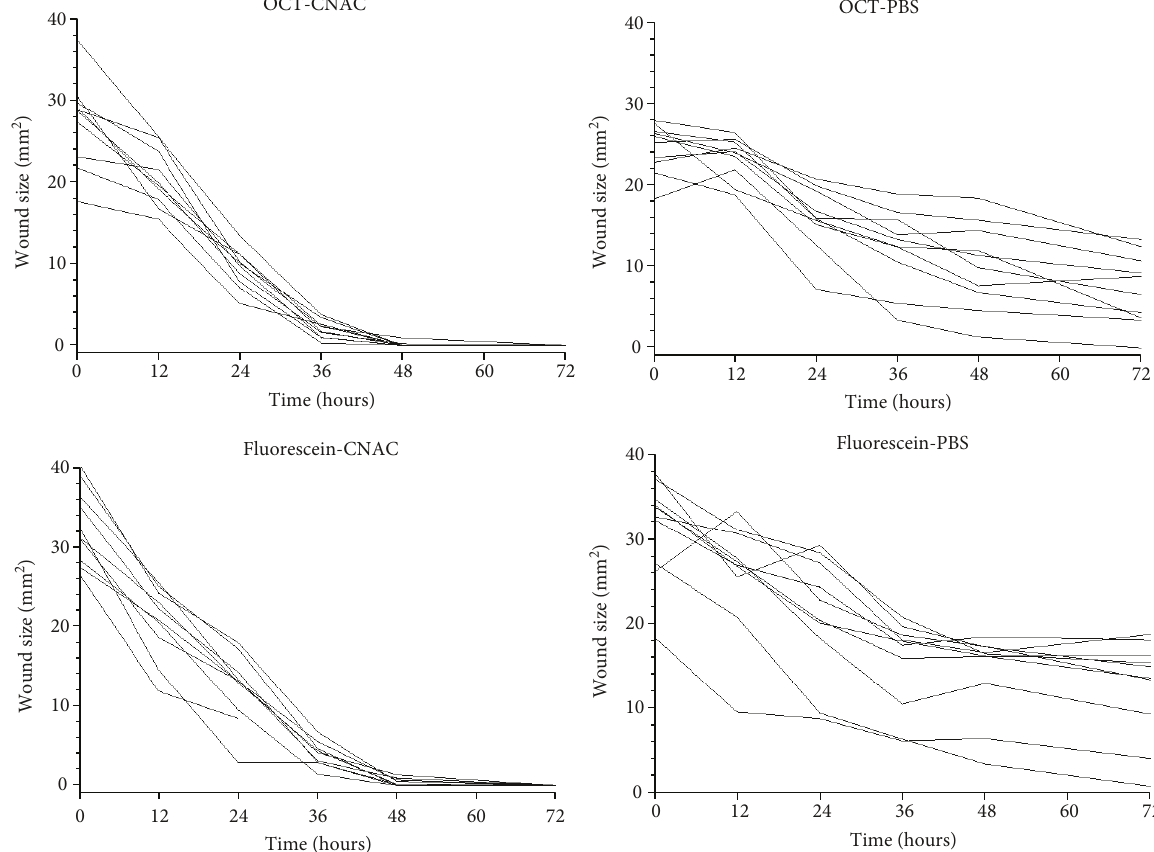
Figure 1: Area of defect over time after treatment with either placebo or C-NAC. Data are presented individually based on either fl uorescein staining of corneal epithelium or optical coherence